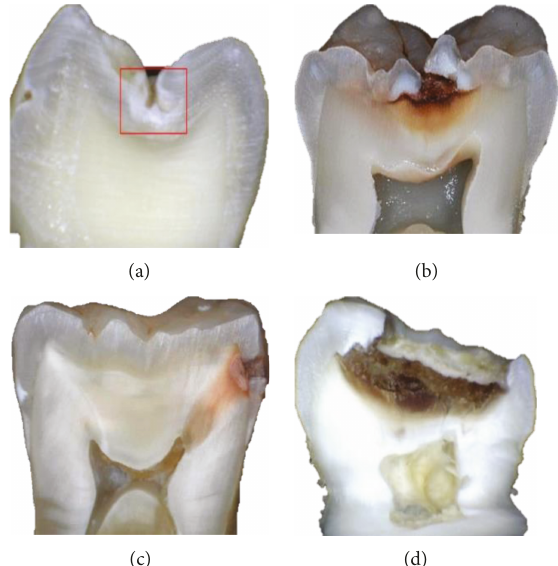
Figure 3: Stages of carious lesions. (a) First stages (enamel), (b) second stages (enamel and dentin), (c) third stages (a ff ectation of the dental nerve), and (d) fourth stages (destruction of